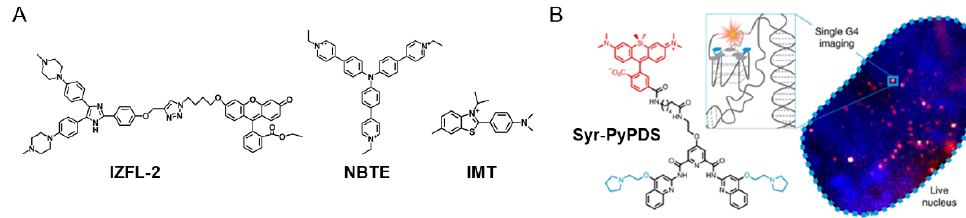
Figure 5. Fluorescent G4 probes. ( A ) Common name and chemical structures of IZFL-2, NBTE and IMT. ( B ) Chemical structure of SiR-PyPDS and single-molecule fluorescence imaging of G4s in living cells using the fluorescent probe SiR-PyPDS. Adapted with permission from ref. [97] Copyright 2020 Springer